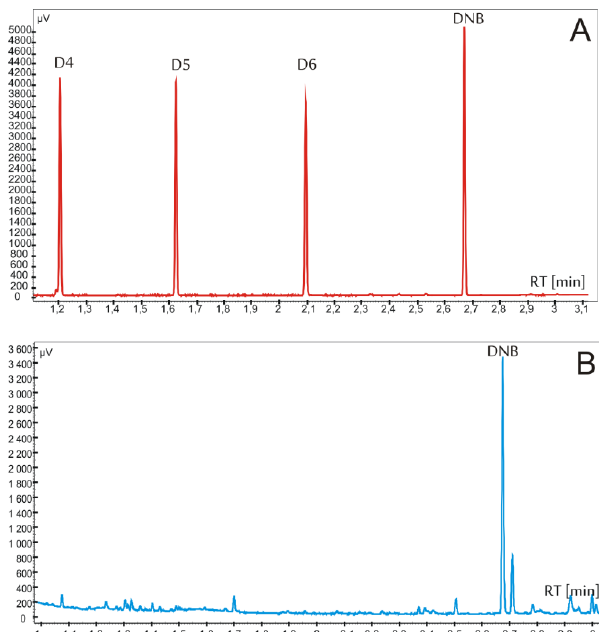
Figure 2. ( A ) separation of chromatographic peaks of the analyzed compounds D4, D5, and D6 and internal standard (DNB, 5 µ g / mL); ( B ) example of matrix sample (stratum corneum).